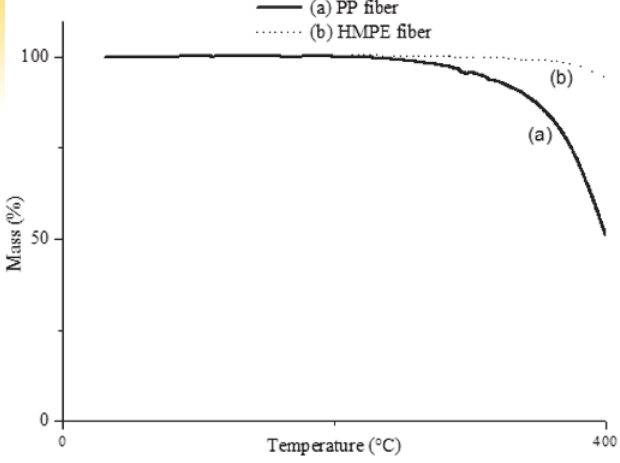
Thermogravimetric analysis of PP fiber and HMPE fiber